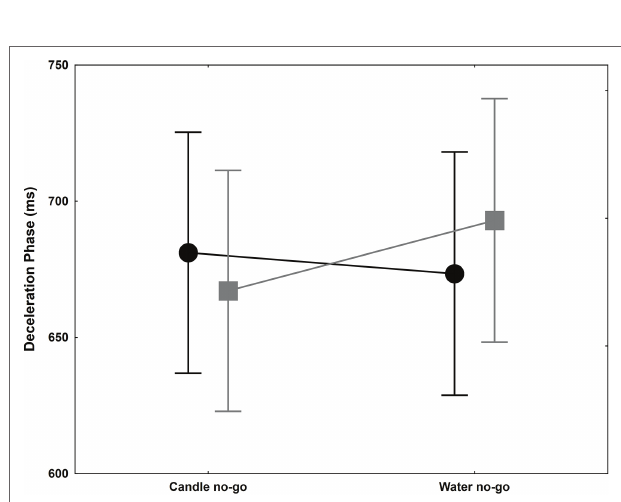
FIGURE 4 | Deceleration phase (ms) +/− SEM for control (black circle) and thirsty groups (gray square) when they reached and grasped the candle glass and precluded either by a candle no-go or water no-go trial. This phase is slightly shortened in the control group while it was significantly lengthened by 25 ms in the thirsty group.